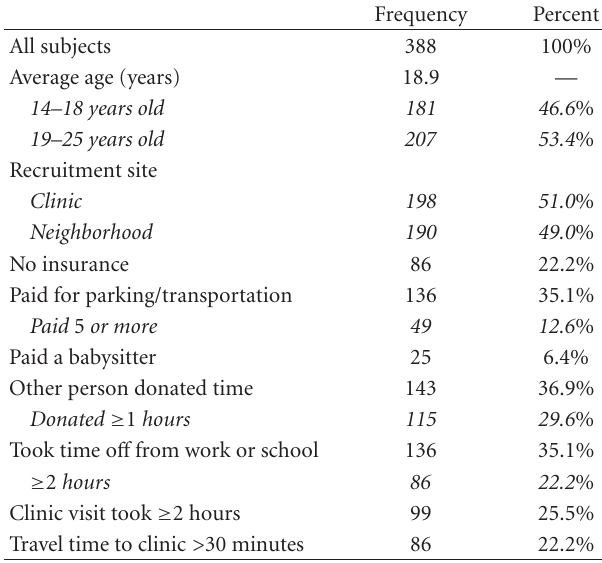
Table 1: Demographic and economic questionnaire data from the DAISY